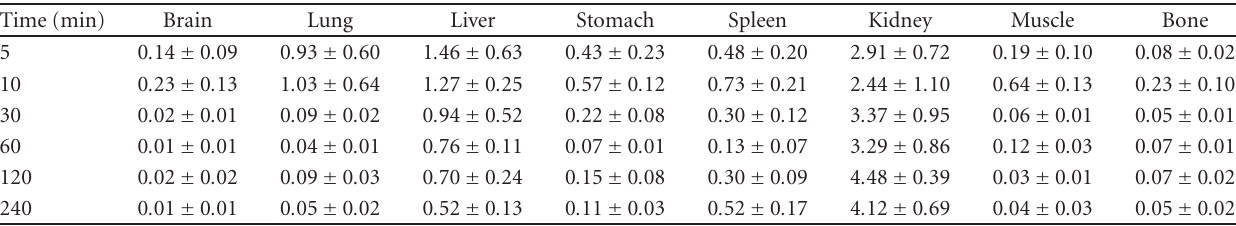
Figure 1: (a) Examples of the radiochemical purity studies from Protocol A and Protocol B. Both showed the RCP result of 30min after radiolabeling. Radiochromatograms were acquired with a radio-TLC scanner. (b) Radiochemical purity and stability tests of the preparation protocols, determined by ITLC and presented as %RCP with mean ± SD ( n = 6). Table 2: In vivo biodistribution of the 99m Tc-autoalbumin, expressed as percentage of administered dose per gram of organ (%ID/gm) (mean values ±